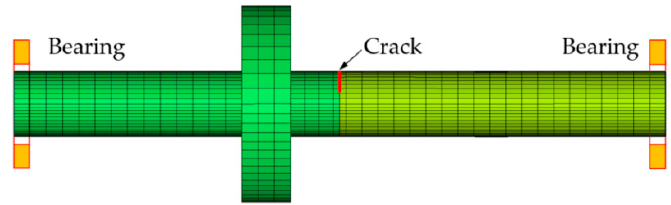
Figure 3. The finite element model of a cracked rotor-bearing system.